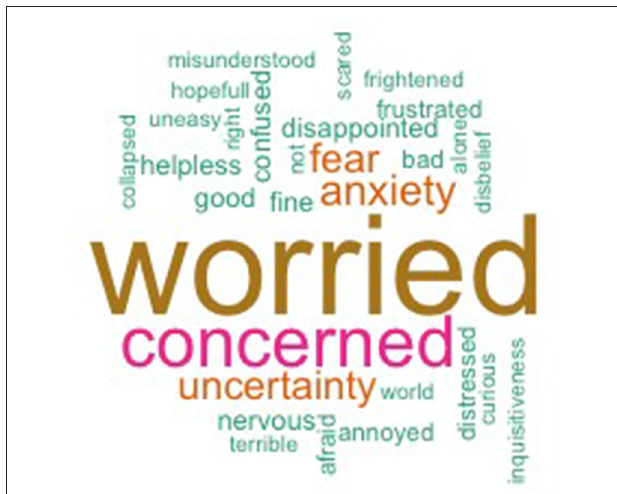
FIGURE 4 | Reported feelings during stage 3. Words grouped after coding, ones with minimum frequency of 2 are included in figure ( n = 28). Full list ( n = 62) can be found in Supplementary Material 3